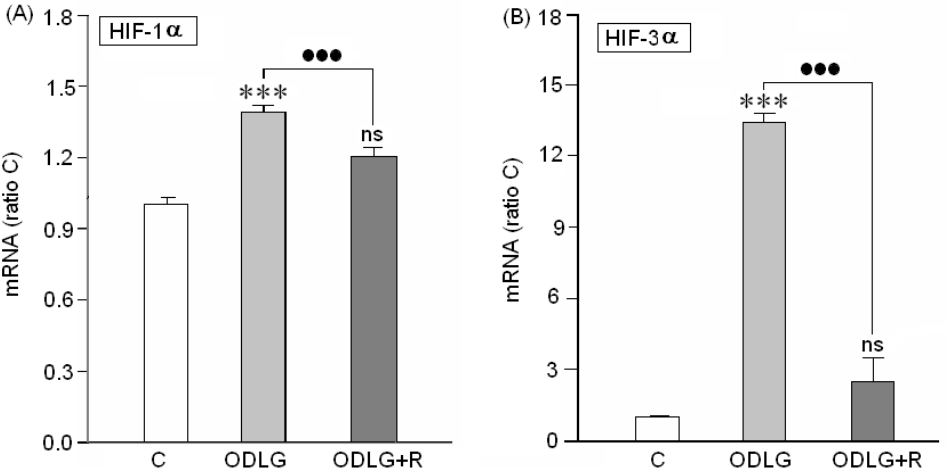
Figure 2. Effect of different ODLG treatment time on ROS formation. Reperfusion = Cortical neurons after the ODLG treatments were subjected to 24 h under a normal atmosphere after the ODLG treatment. Results are means ± SEM of three experiments with cells from different cultures, each one performed in triplicate with different batches of cells (9 measurements/condition). ns = no significant ( vs.